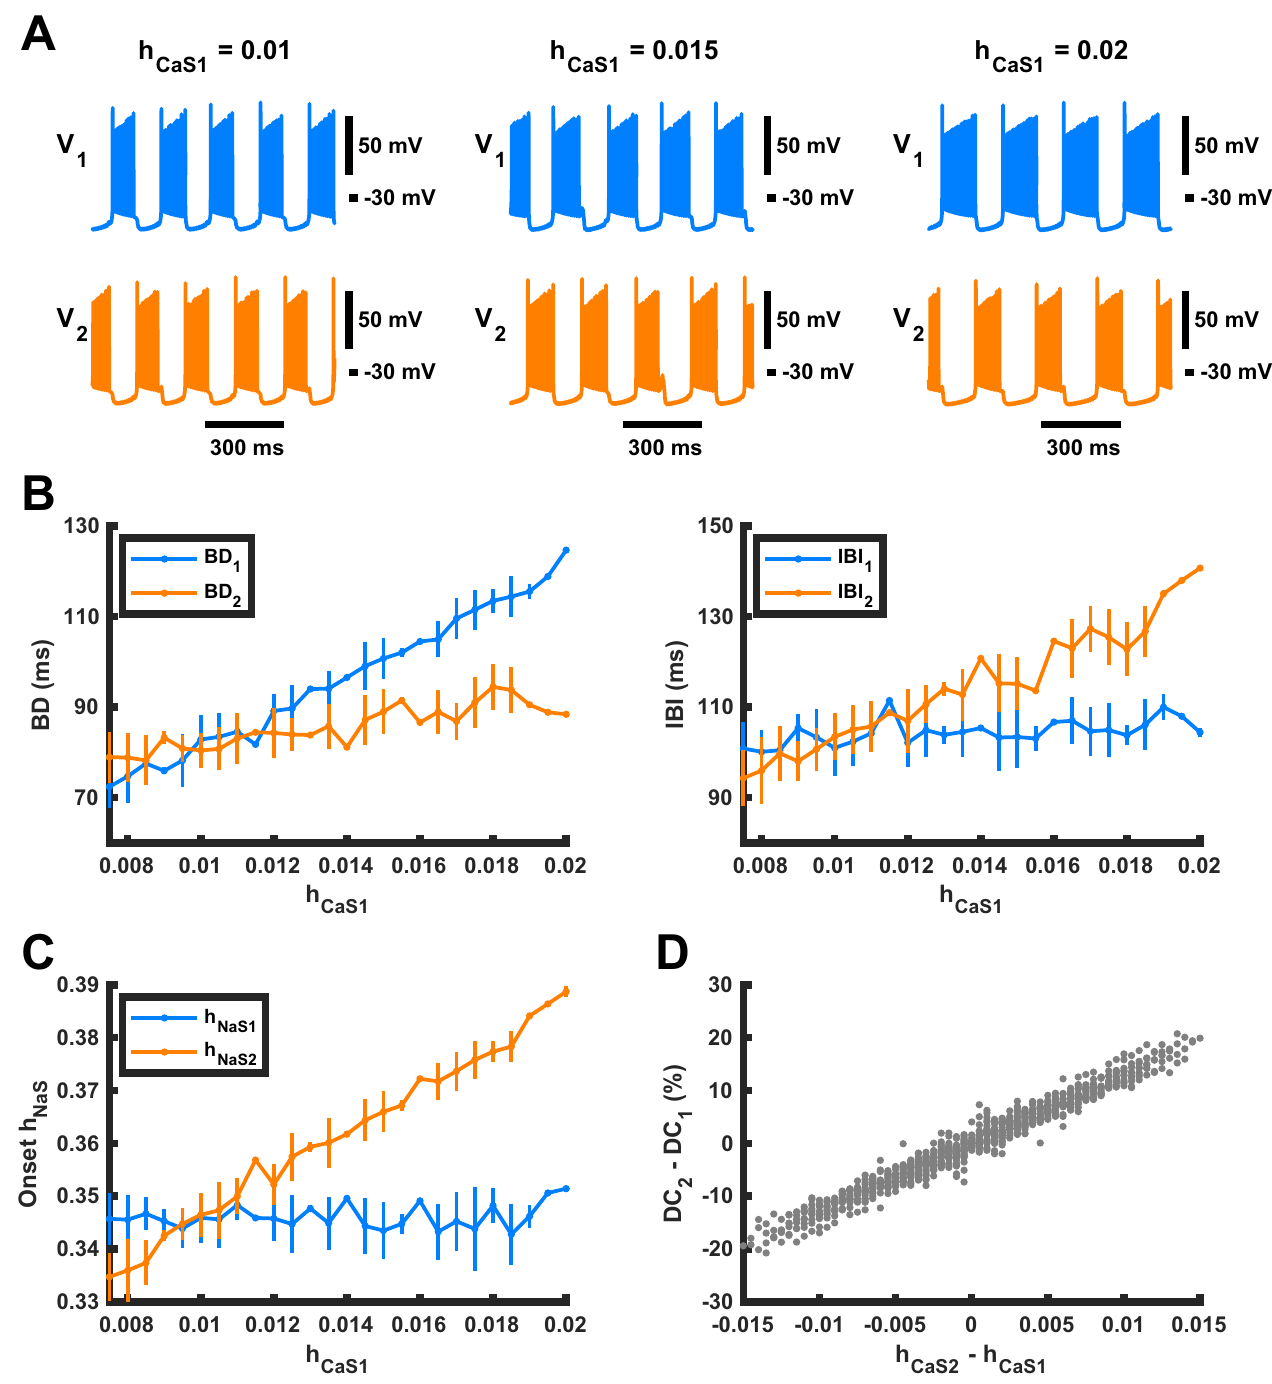
Fig 7. Dependence of burst duration (BD) and interburst interval (IBI) in model HCO neurons #1 and #2 on h . (A) Bursting paw-shake-like activity in CaS1 neurons #1 (blue trace) and #2 (orange trace) at different values of parameter h CaS1 , while the value of parameter h CaS2 remained constant at 0.01. (B) In the reduced constant- h model, BD 1 and IBI 2 increased substantially with increasing h , while IBI 1 and BD 2 only slightly increased. (C) The onset h CaS CaS1 NaS2 increased linearly while onset h NaS1 stayed roughly constant. (D) The difference in duty cycle between the two neurons depends linearly on the difference in h CaS between the two neurons. This dependence was calculated using every simulated combination of h CaS1 and h CaS2 , where both h CaS parameters were varied from 0.0075 to 0.02 with steps of